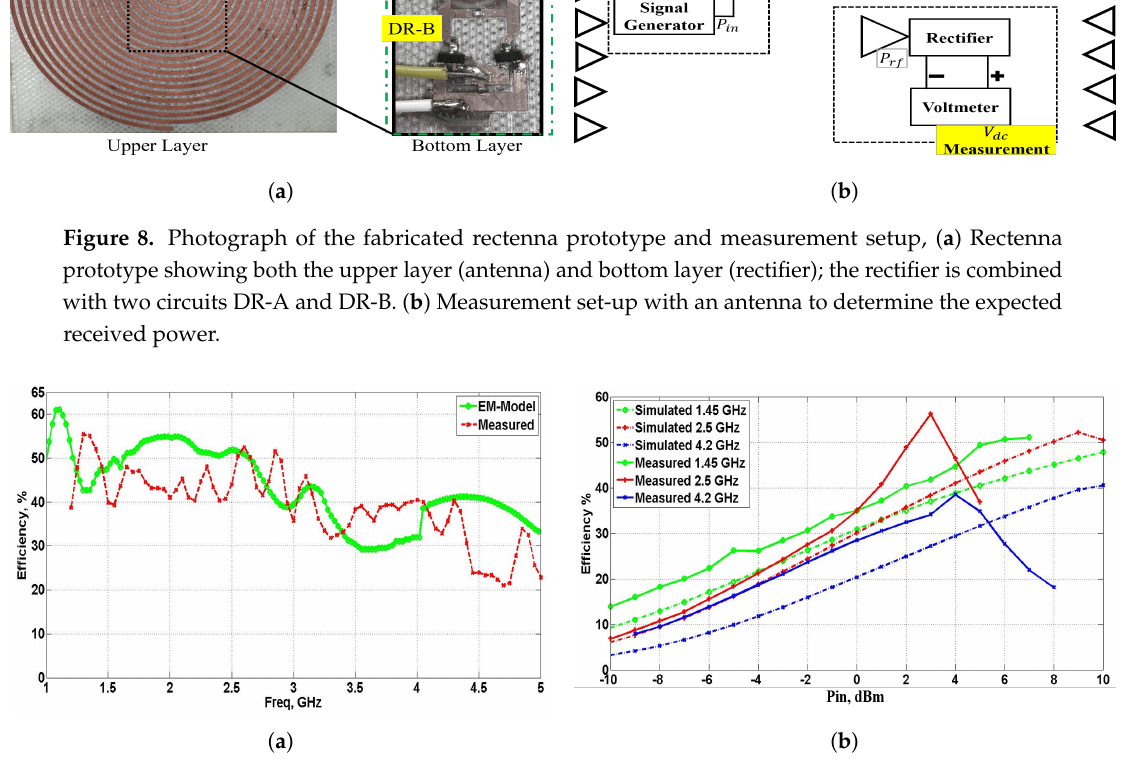
Figure 9. Rectenna measurement and simulated results. ( a ) Efficiency versus frequency at simulated P in = 9 dBm, R L = 1 k Ω . ( b ) Efficiency versus input power for R L =1 k Ω and at different input